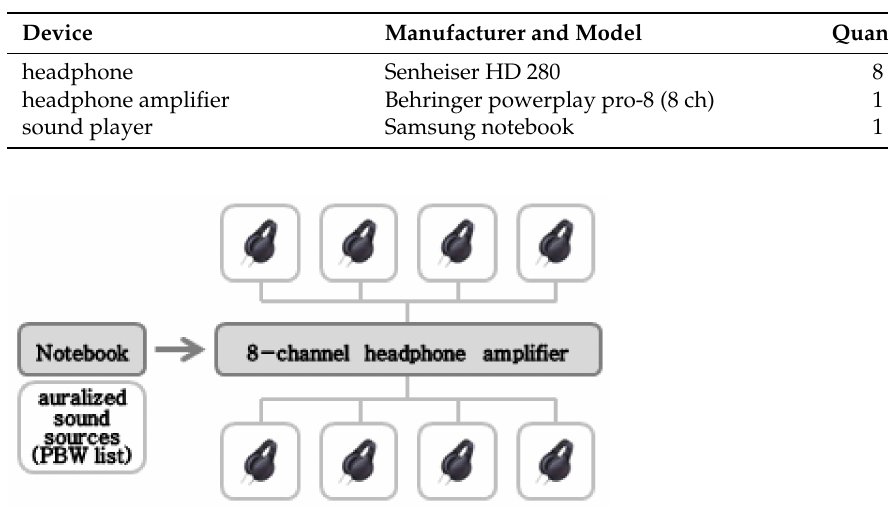
Figure 8. Equipment configuration diagram for the speech intelligibility test.